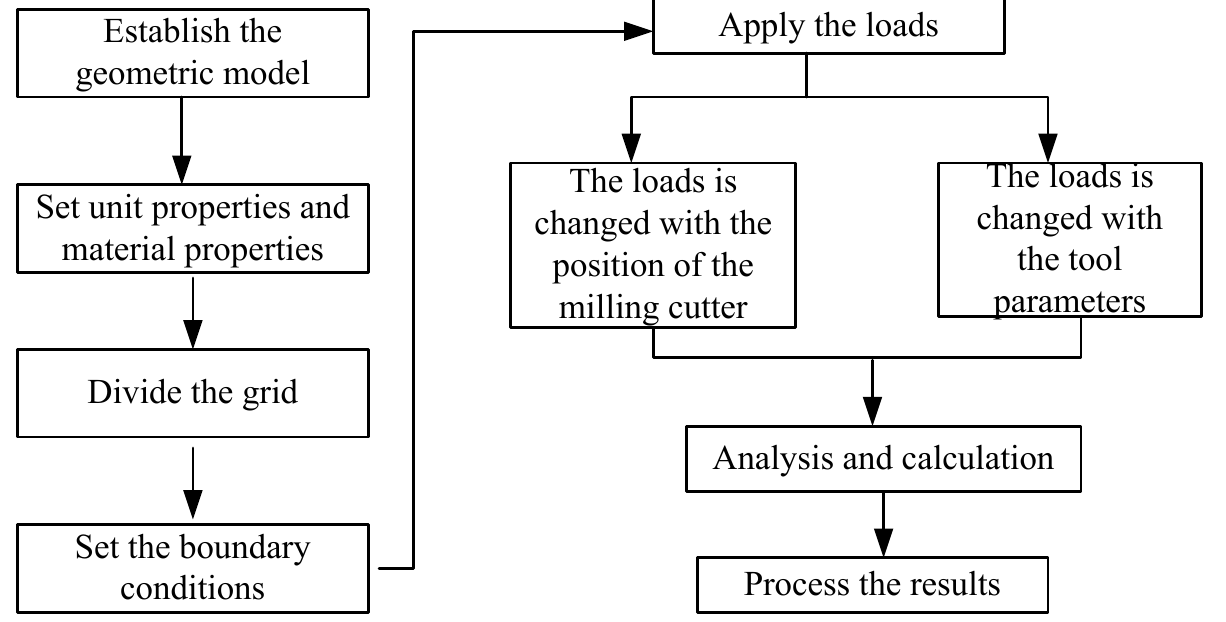
Figure 2. Finite element analysis flow chart.